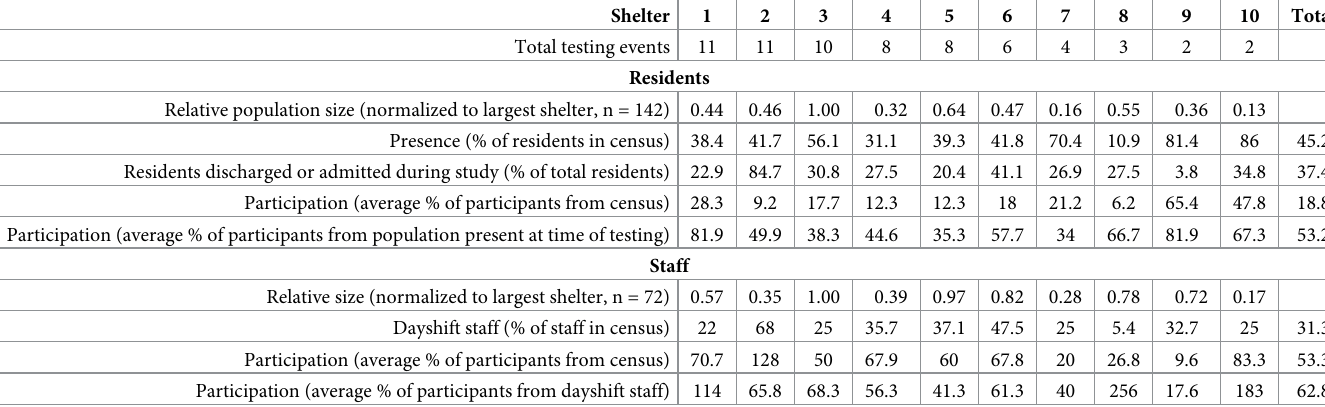
Table 4. Participation in shelters included in the pilot implementation of rapid SARS-CoV2 antigen testing, San Francisco, 2021.